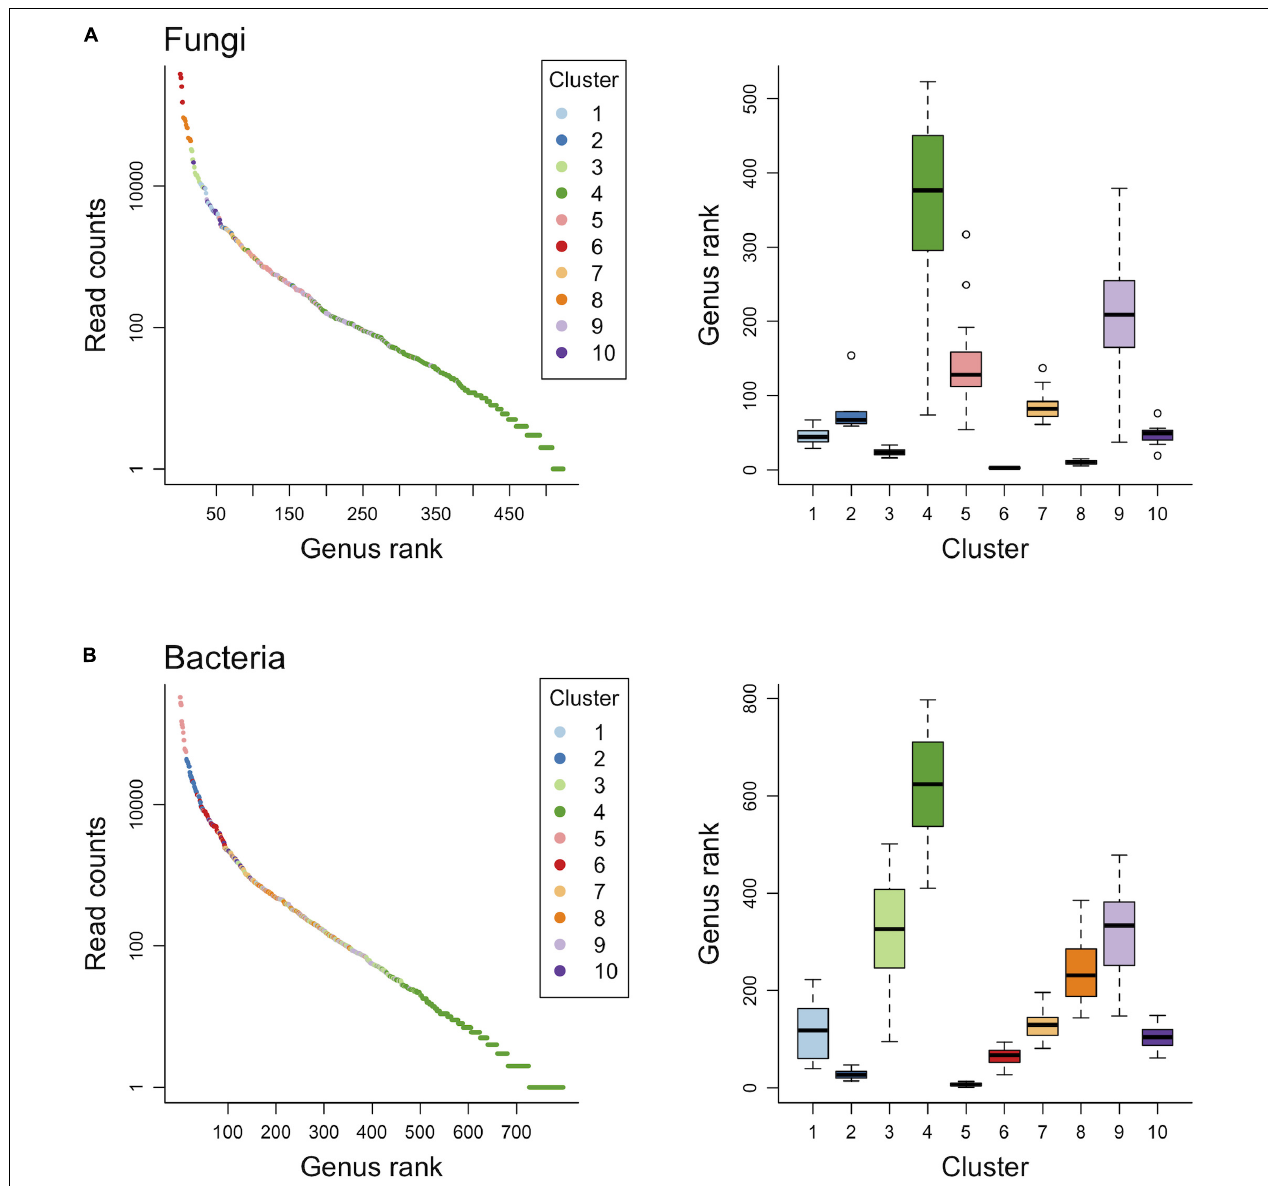
FIGURE 3 | Genus level rank abundance distribution and the range of genus rank per cluster for fungal (A) and bacterial (B)